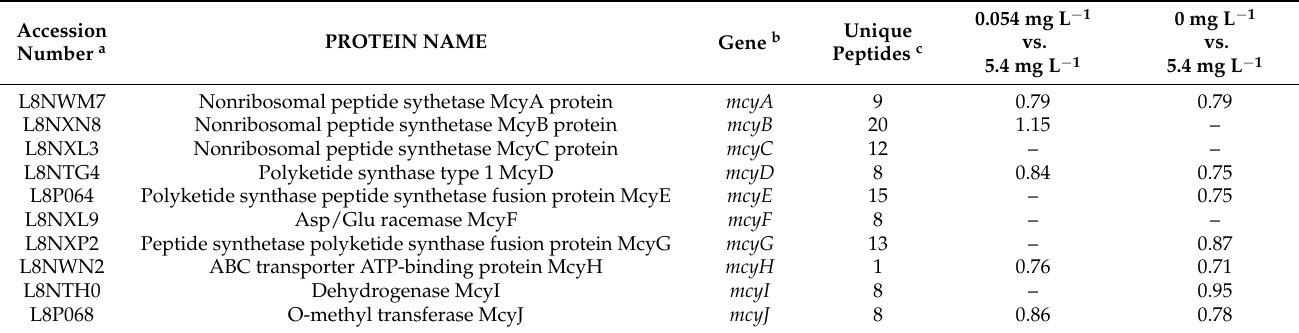
Table 2. Relative abundance of ten microcystin synthetic proteins in Microcystis aeruginosa FACHB-905 grown upon phosphorus depletion. All relative abundance listed were statistically significant ( p < 0.05).